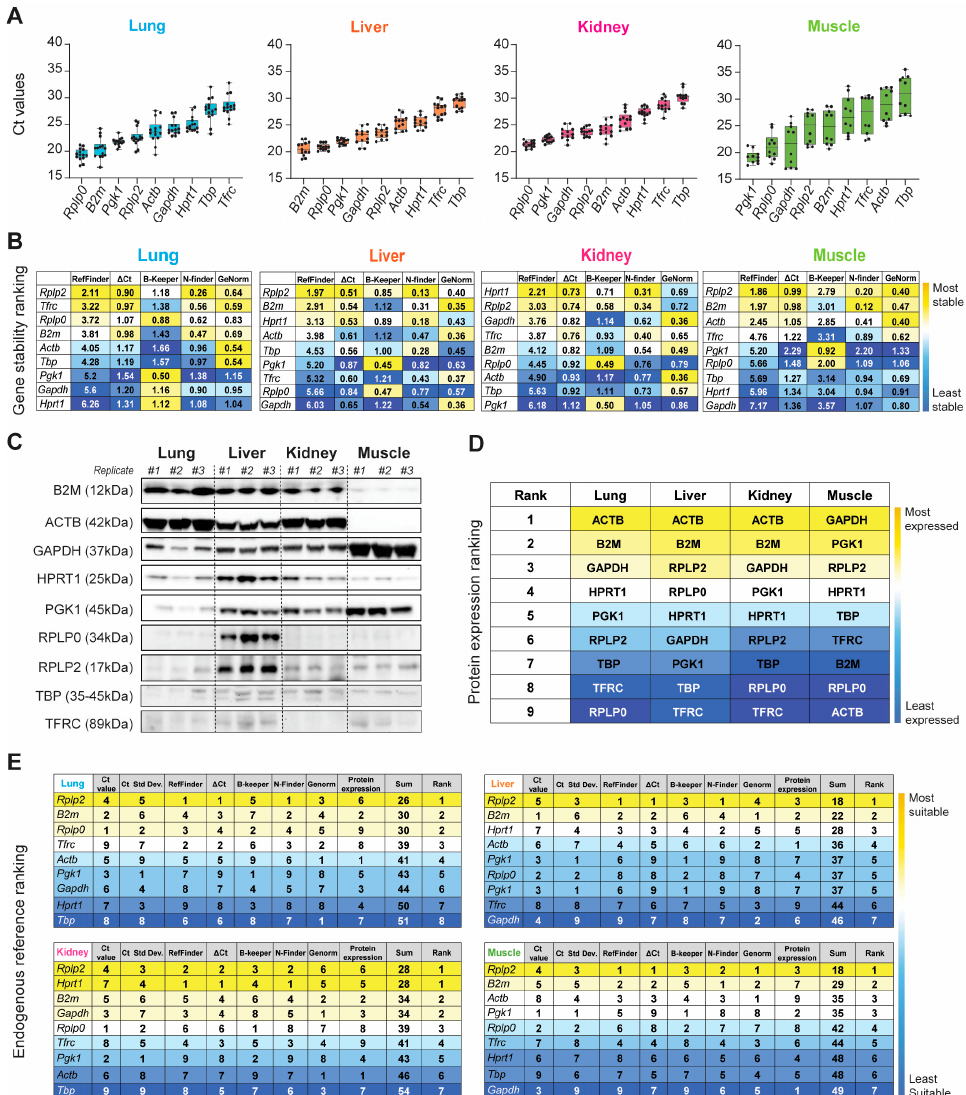
Figure 3. Evaluation of gene expression, stability, and translation of the nine HKGs between the lung, liver, kidney, and muscle tissue in naïve rats. ( A ) Ascending order distribution of the raw mean Ct values of the nine HKGs (n ≥ 10). Error bars represent the standard deviation of the mean. ( B ) Heatmaps representing the gene stability rankings obtained with RefFinder, Delta Ct ( Δ Ct), BestKeeper (B-Keeper), NormFinder (N-finder), and GeNorm for the nine HKGs. The color scale represents the most stable gene (yellow) to the least stable gene (blue; n ≥ 10 rats). ( C ) Representative Immunoblots against the 9 HKGs obtained with 15 µg of total protein loaded. (n = 3 biological replicates indicated as #1, #2, and #3). ( D ) Protein expression ranking for the nine HKGs. The color scale represents the most (yellow) to the least (blue) abundant protein expression. Results extrapolated from immunoblots presented in naïve. ( E ) Ranking of the nine HKGs according to their Ct value, Ct value standard deviation, gene stability from the five algorithms, and protein expression level. The color scale represents the most (yellow) to the least (blue) suitable endogenous reference.